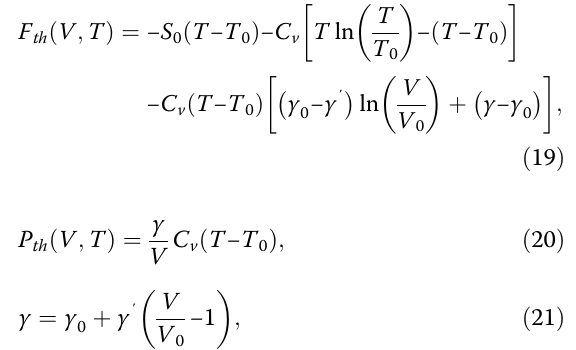
(e.g., Additional file 1: Figure S5e). The bridgmanite is